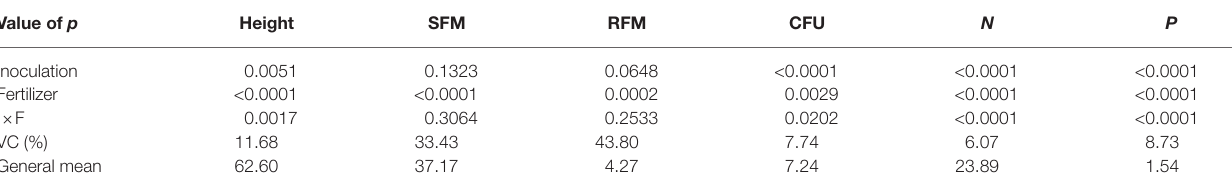
TABLE 2 | Height, SFM, RFM, CFU of endophytic Bacillus subtilis recovered from soybean roots, and nitrogen and phosphorus concentrations in maize plant shoots as a function of fertilization dose. Value of p